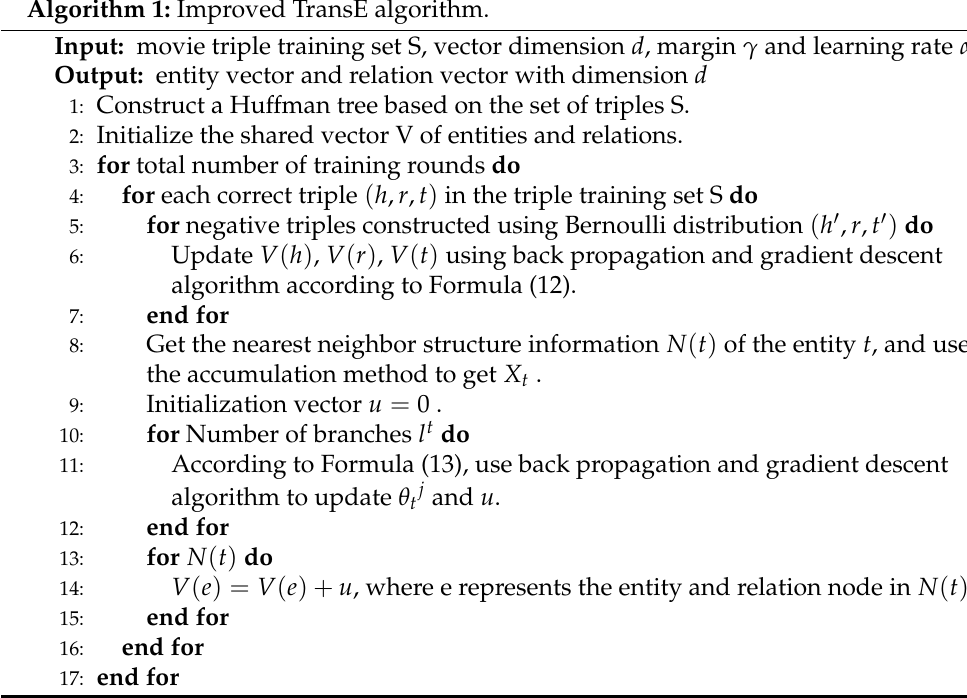
Algorithm 1: Improved TransE